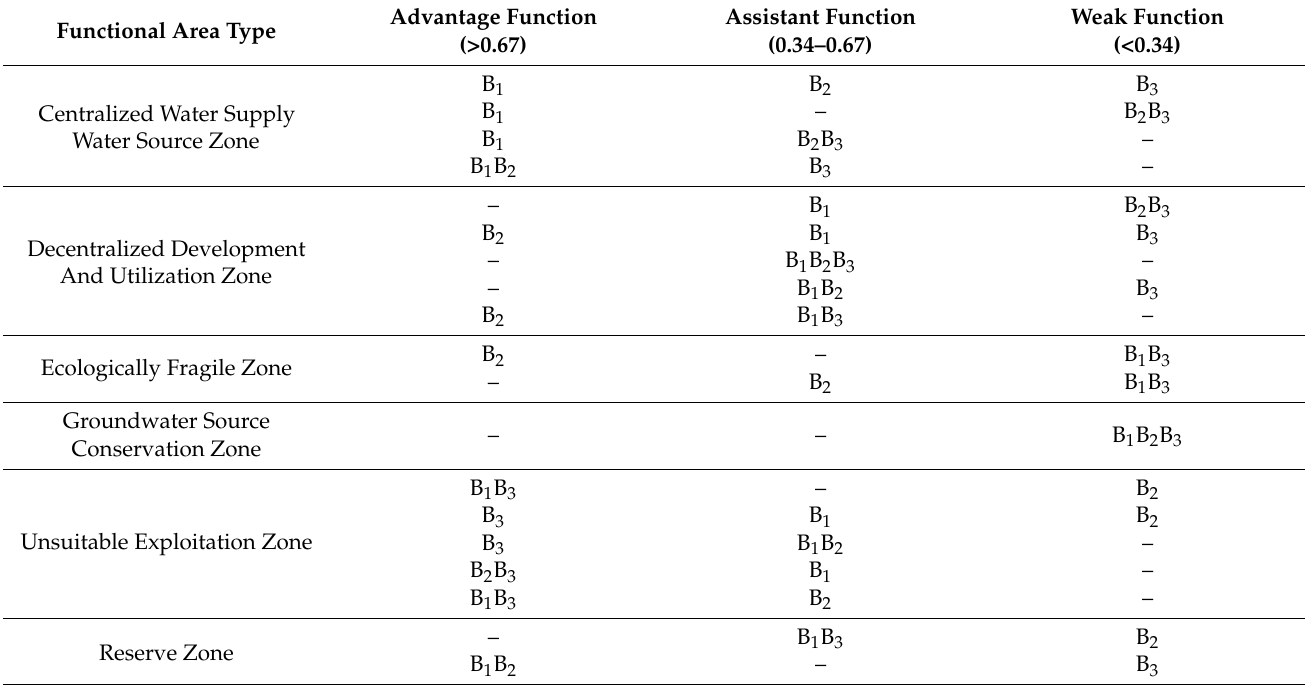
Table 3. Second-level functional zoning score system for shallow groundwater in the study area. Functional Area